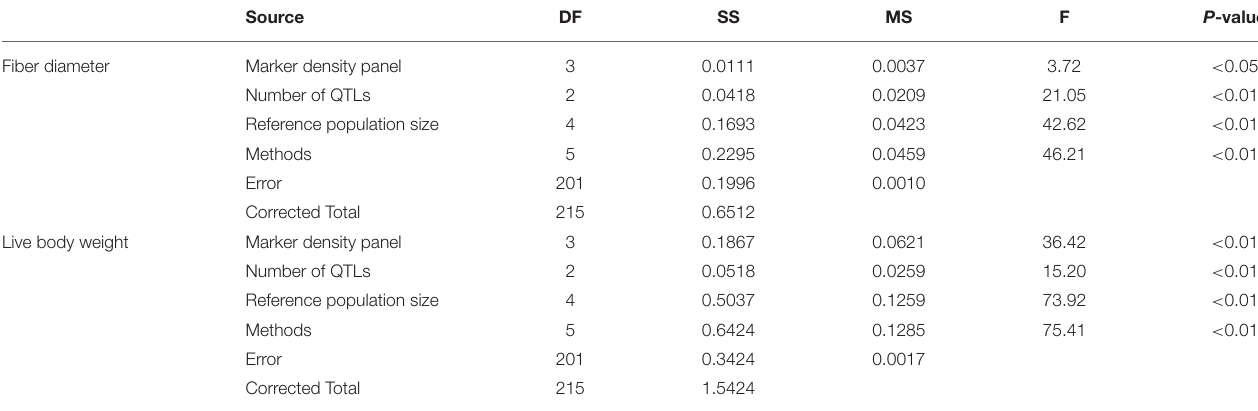
TABLE 2 | Variance analysis of different factors on the accuracy of GEBV for fiber diameter and live body weight.